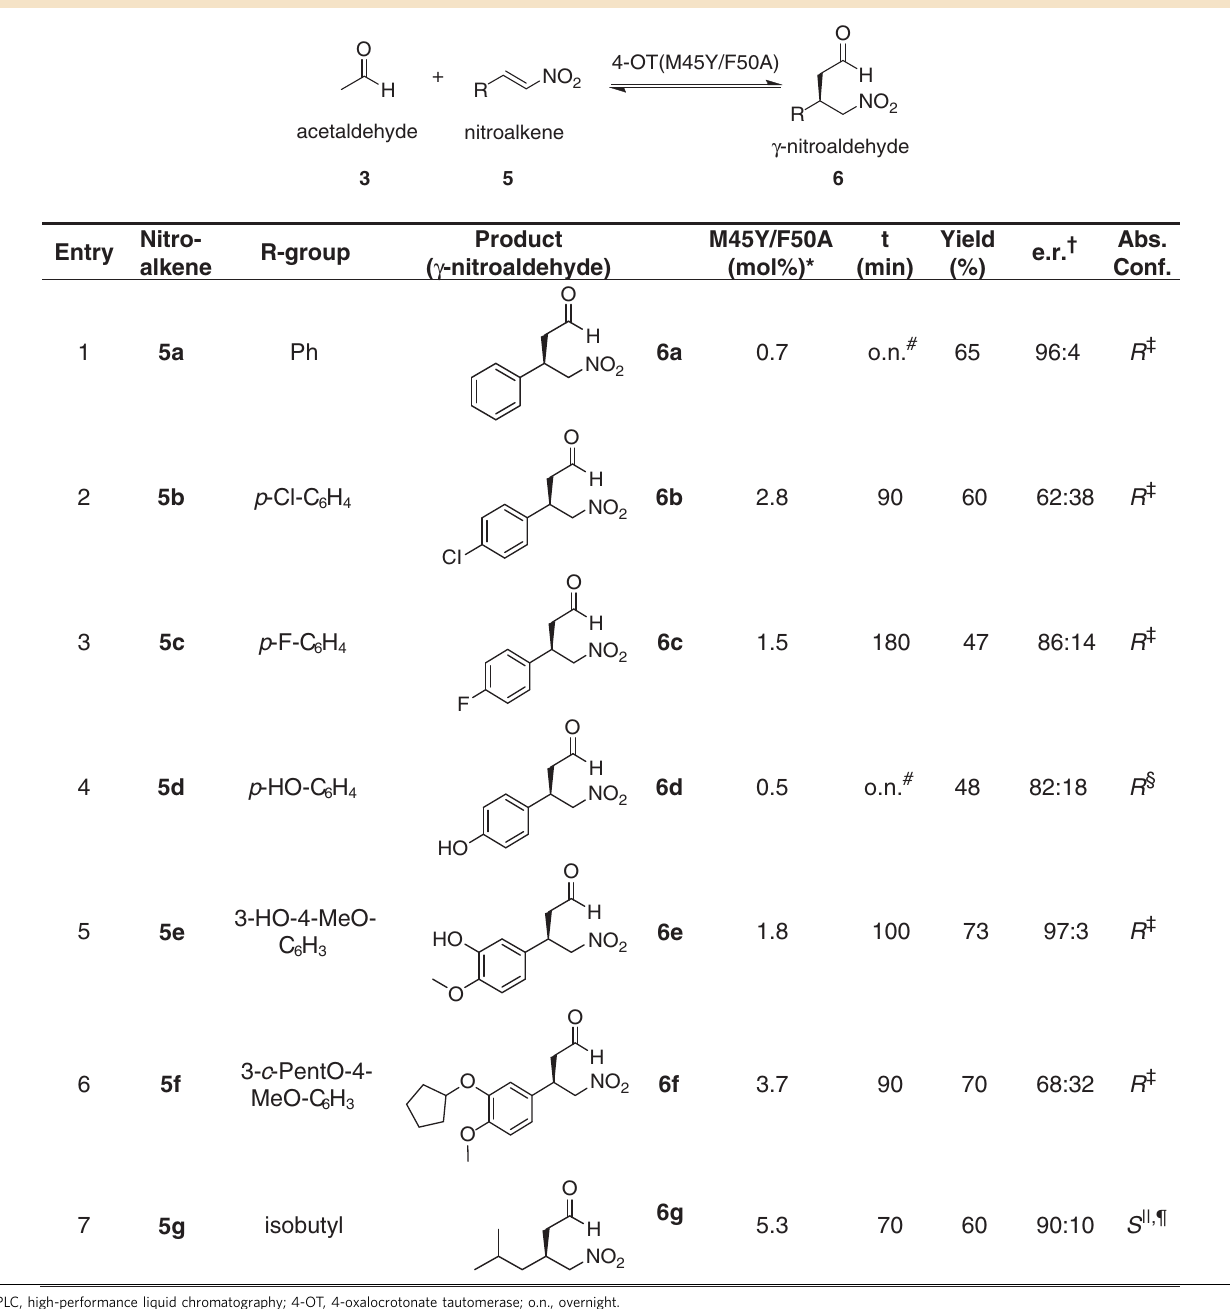
Table 3 | 4-OT(M45Y/F50A)-catalysed acetaldehyde addition to nitroalkenes 5a–5g.